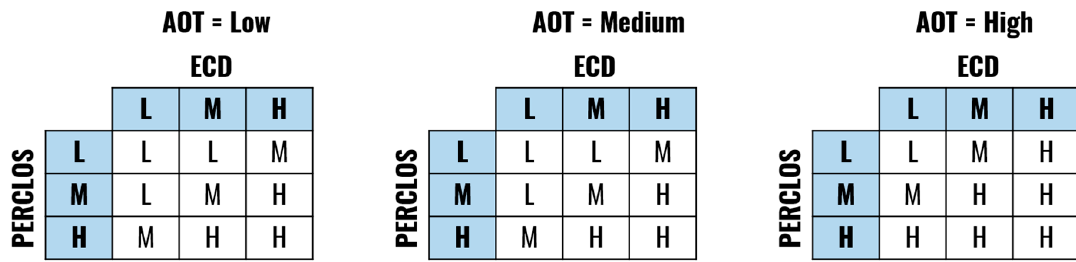
Figure 6. Fuzzy membership functions for drowsiness level output.